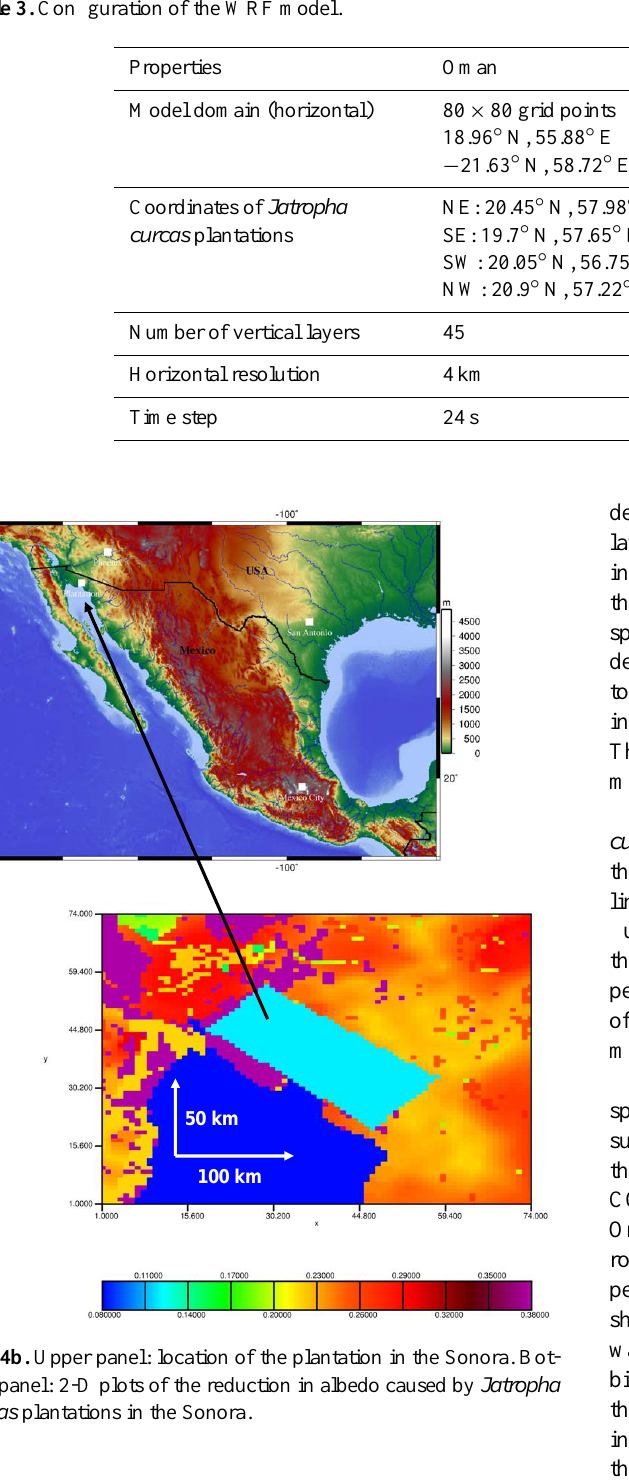
depth, the cloud coverage, the rain rate, and the formation of dew were also